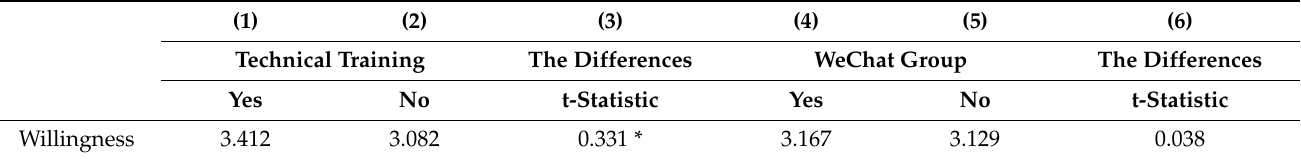
Table 2. Comparison of adoption willingness of different types of